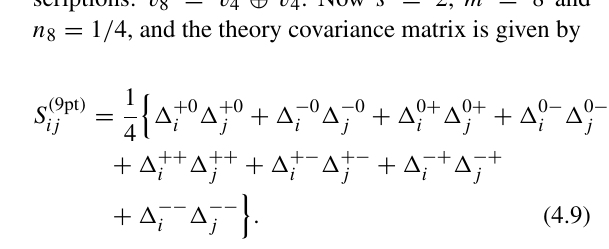
Fig. 2 Symmetric prescriptions for a single process, indicating the sampled values for the factorization scale κ f and renormalization scale κ r in each case. The origin of coordinates corresponds to the central